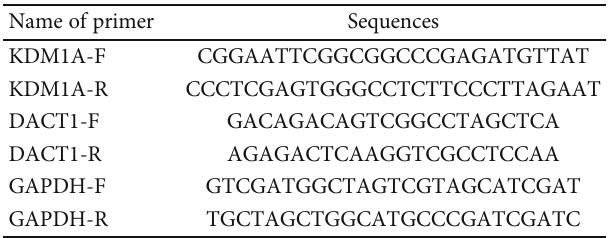
Table 1: Primer sequences for reverse transcription polymerase chain